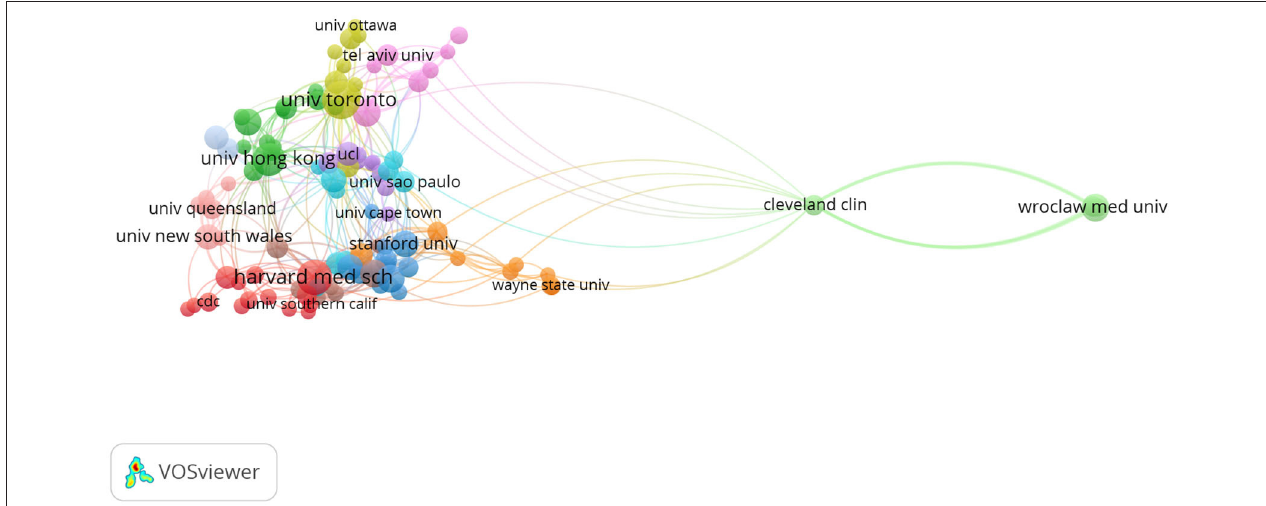
FIGURE 4 | Network visualization map of co-authorship institutions. A minimum of five documents per organization was fixed. Of the 2,403 institutions, 116 meet the threshold.